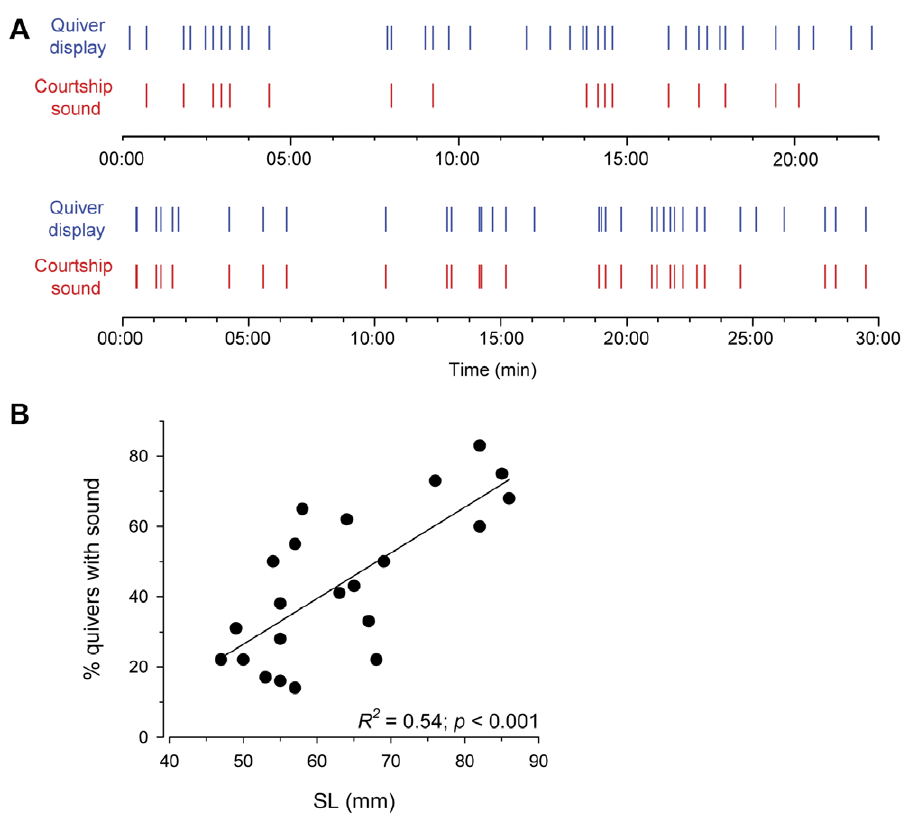
Figure 2. Dominant male A.burtoni produce intentional sounds during courtship quivers. A) Examples of the temporal sequence of courtship sounds and quiver behaviors produced by two individual males of different sizes. Top graph shows a small male (SL=55 mm) that produced courtship sounds during , 40% of behavioral quiver displays, while the bottom graph shows a larger male (SL=82 mm) that produced sounds during , 80% of quivers. Each vertical mark represents a single courtship sound or quiver behavior during the 30 min trial. B) Relationship between the percentage of quiver behaviors associated with courtship sounds and male standard length (SL) shows that larger males produce a greater proportion of behaviors with sounds than do smaller